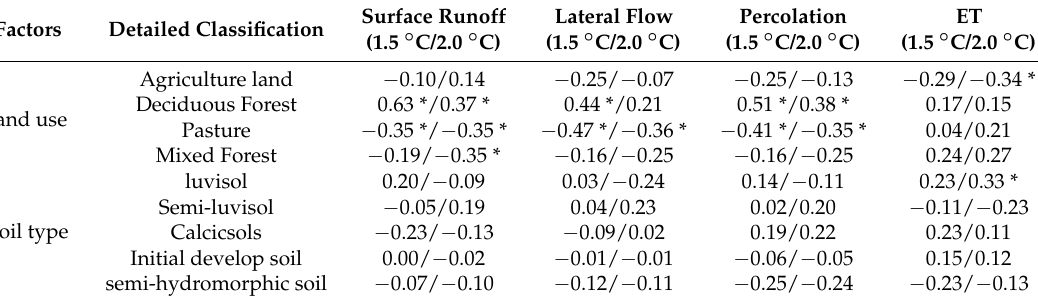
Table 4. Correlation coefficient of percentage change in WBC and land use, soil type.